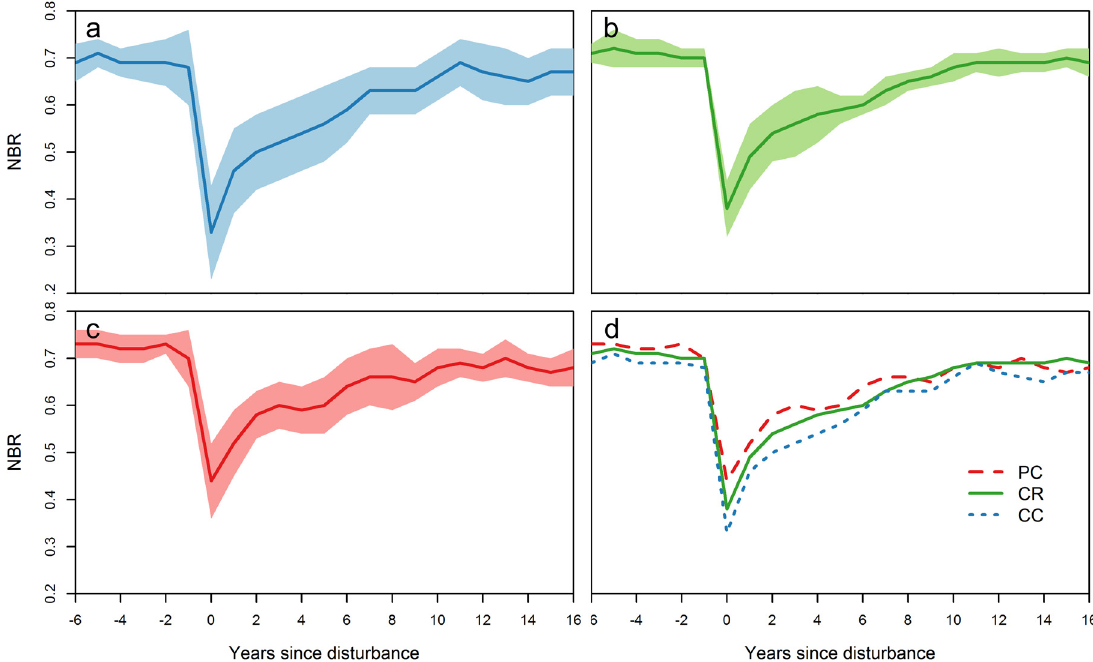
Figure 6. Average and standard deviation of Normalized Burn Ratio (NBR) spectral values per harvest practice: clearcut ( a ), residual cut ( b ) and partial cut ( c ), and comparison of the averaged spectral values: clearcut (CC), clearcut with residual (CR), and partial cut (PC) ( d ).